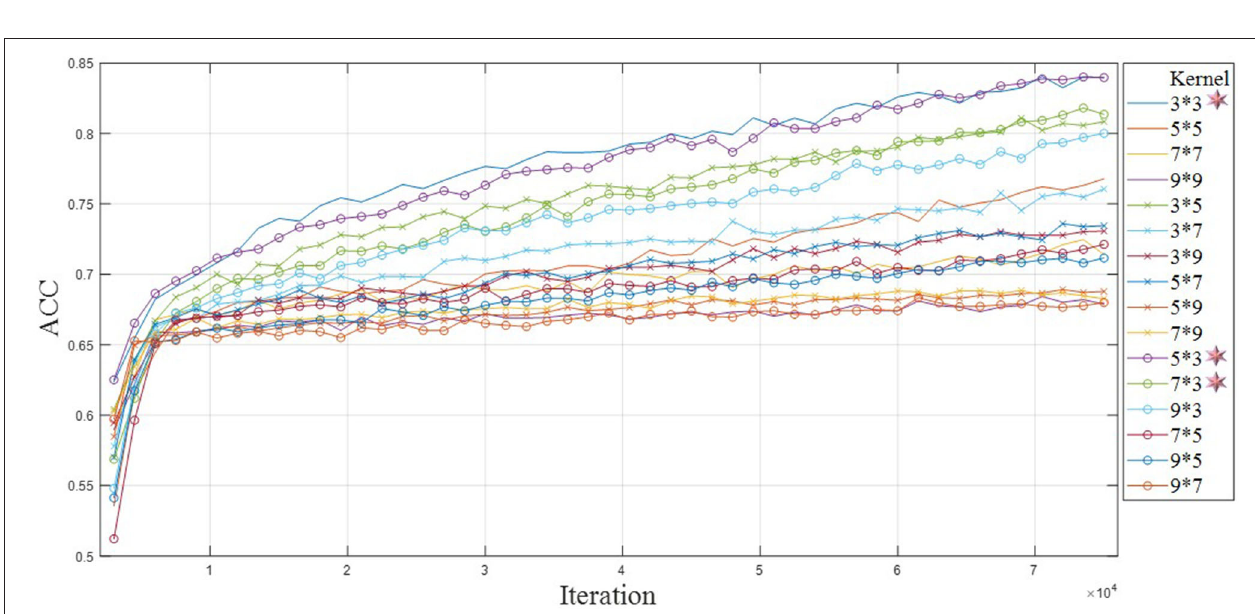
FIGURE 6 | Network training loss of single-scale convolution kernel. (a) The important inflection points of network loss convergence. The loss functions of different convolution kernels decrease rapidly before 1,000 iterations. Additionally, the loss function curves of all convolution kernels tend to be flat before 3,000 rounds. (b) The loss function performance of different convolution kernels after multi-round iteration. Long-shape and small-size convolution kernels are suitable for feature extraction of ERP tasks.